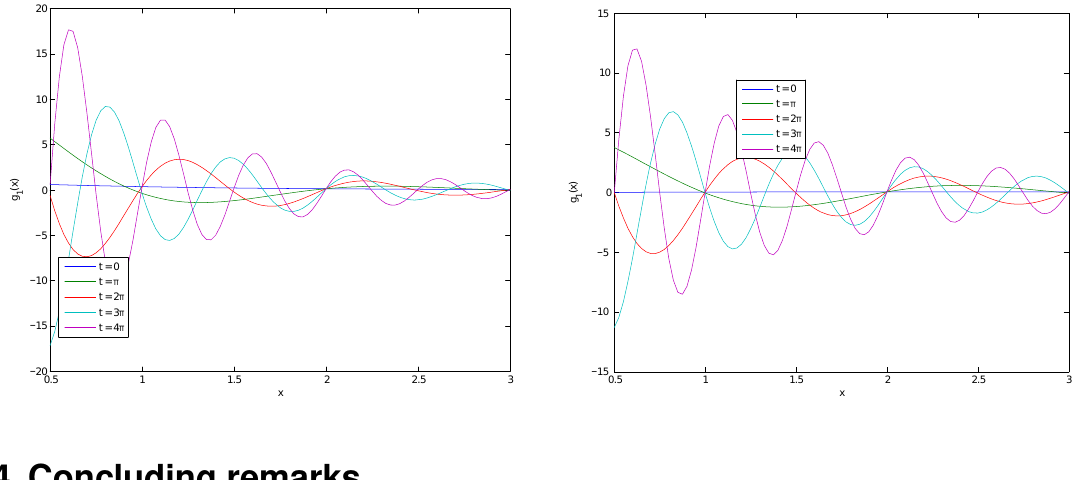
Fig. 4. Exact (top) and approximate (bottom) longitudinal section solution g.x/ when ˛ D 0:8 and g 0 .x/ D e (cid:0)